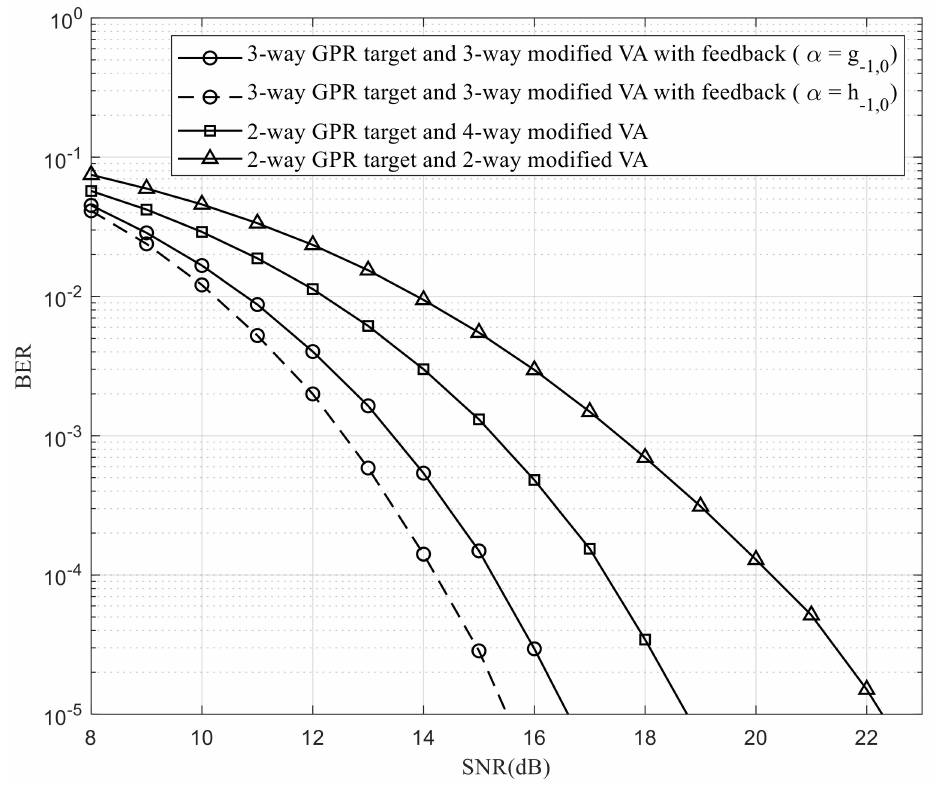
Figure 14. BER performance for our proposed